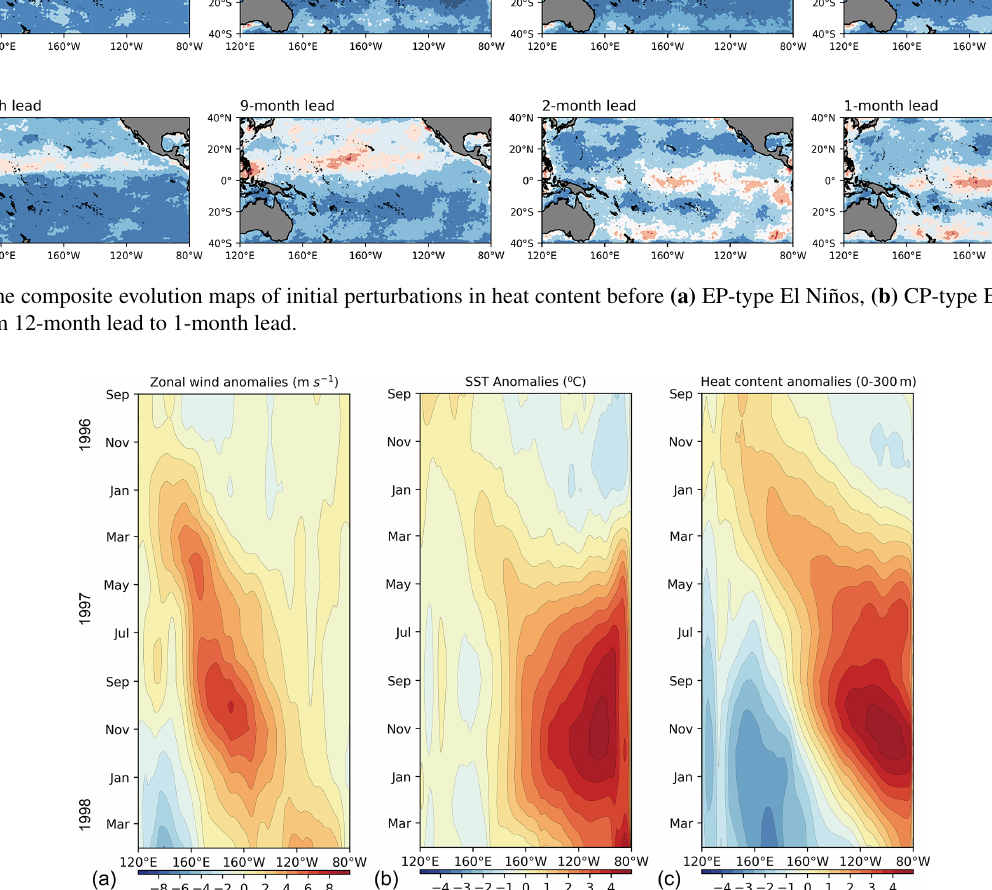
Figure 16. Longitude-time diagram of monthly surface zonal wind anomalies (a) , SST anomalies (b) and heat content (t300) anomalies (c) across the equatorial Pacific (2 ◦ N–2 ◦ S, 120 ◦ E–80 ◦ W) from September 1996 to April 1998. Data are based on NCEP Global Ocean Data Assimilation System and